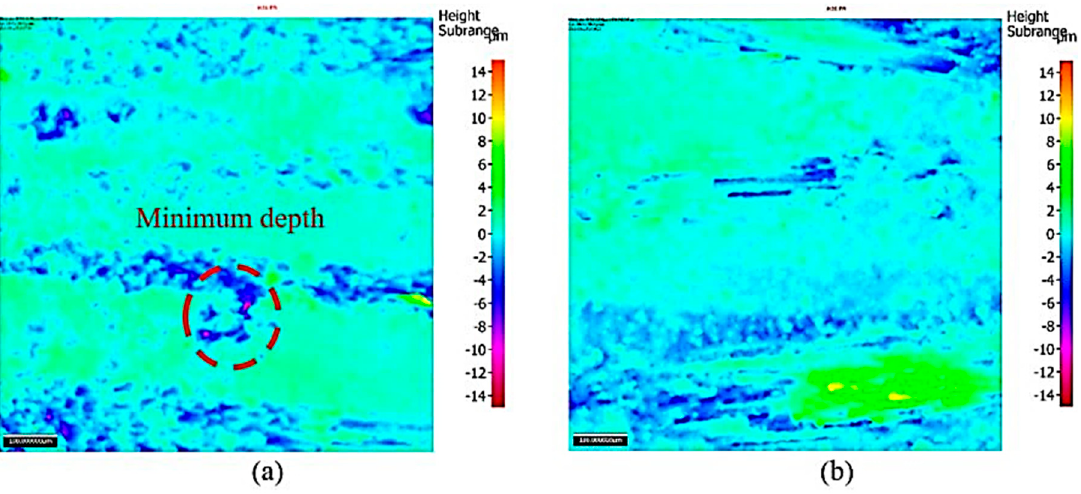
Figure 16. Effect of machining technique on the CFRP surface texture measurement: ( a ) CD; ( b ) LF-VAD at A m = 0.48 mm.